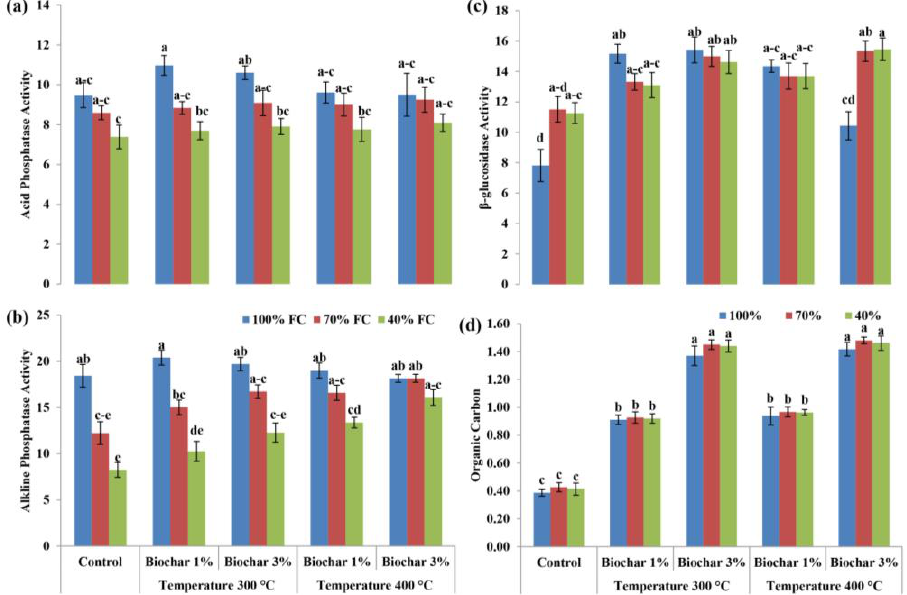
Figure 2. The effect of biochar on soil ( a ) acid phosphatase activity, ( b ) alkaline phosphatase activity, ( c ) β -glucosidase activity, and ( d ) organic carbon under drought stress. Data with different letters are considered significantly different ( p ≤ 0.05).